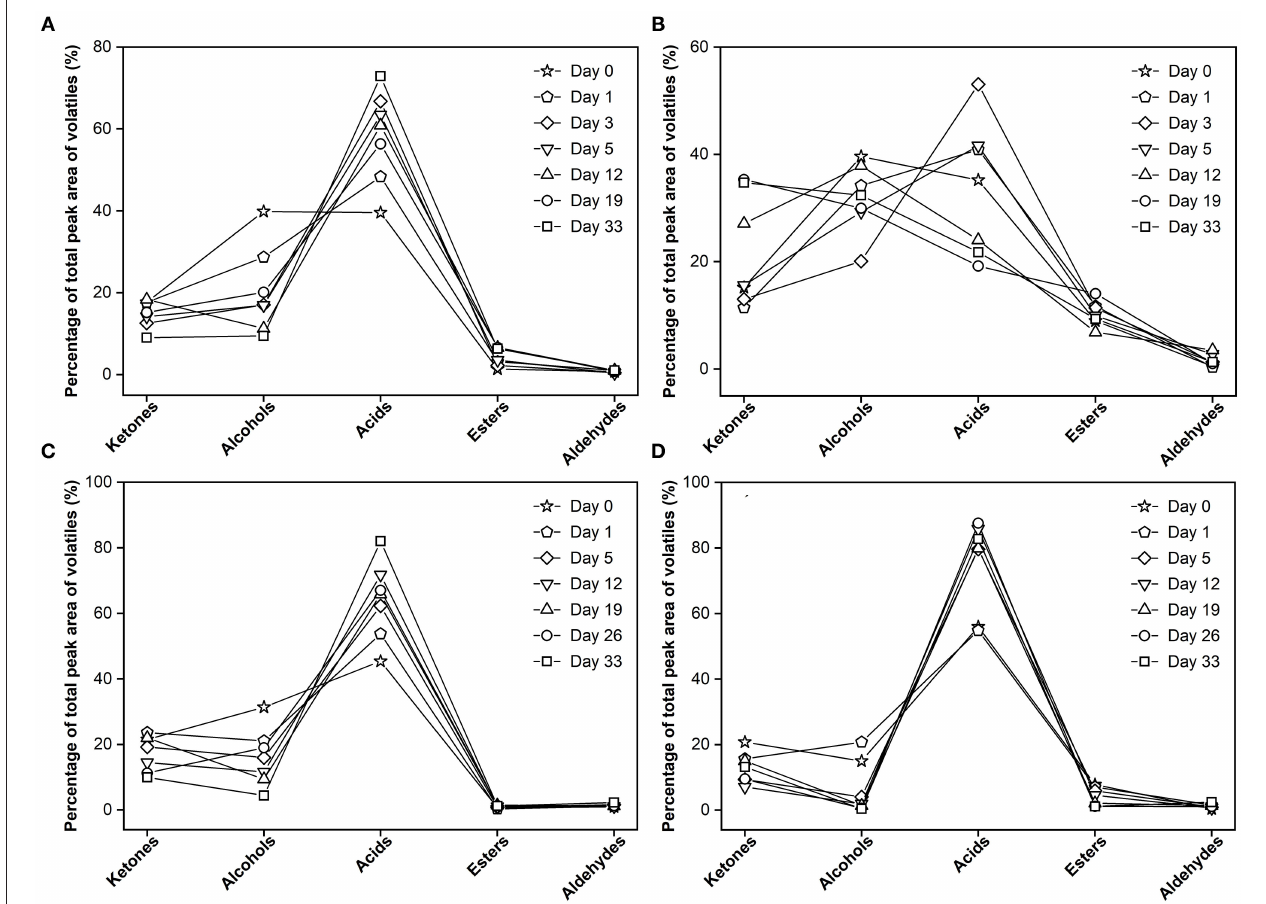
FIGURE 6 | Changes in flavor profile across the 33 days. (A) control group without inoculation of red koji powder, (B) experimental group, (C) control group of surface-ripened Monascus -fermented cheese (MC) (8), (D) surface-ripened MC.